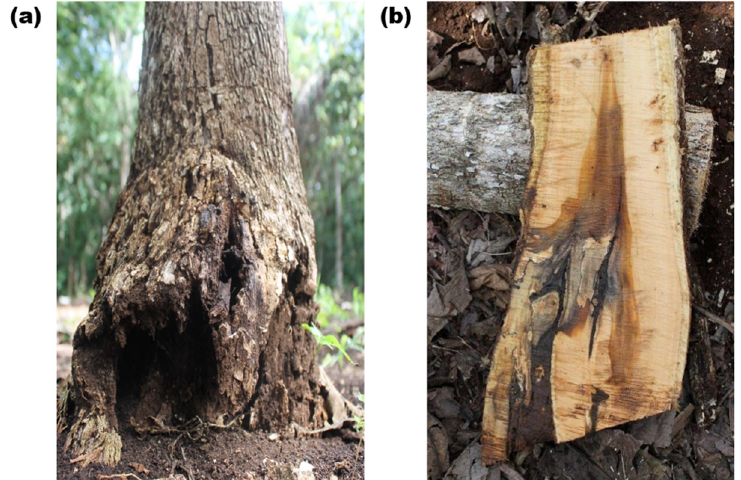
Figure 1. ( a ) Advanced symptoms of root and neck rot of teak, debarking with hyperplasia at stem base, can be observed; ( b ) teak stem cut longitudinally where the progress of the fungus from the base to upper part of the stem can be seen.